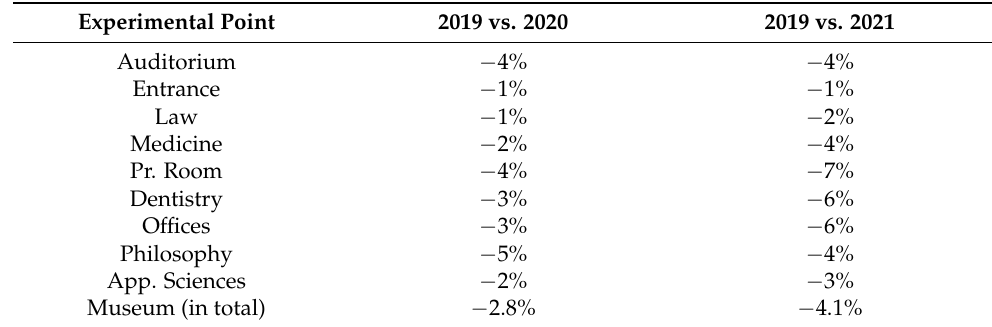
Table 4. Percentages of differences for CO 2 levels within the museum compared to 2019. Experimental